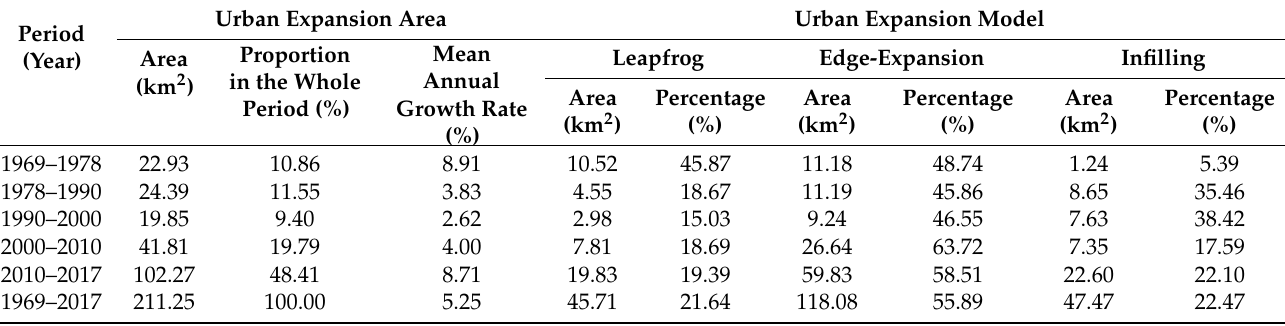
Figure 3. Urban expansion in Xining City. ( a ) spatial patterns of urban land; ( b ) changes in urban land area; ( c ) changes in patch density of urban land; ( d ) changes in the landscape shape index of urban land; ( e ) changes in the mean patch size of urban land; ( f ) changes in the mean altitude of the newly-added urban land; and ( g ) the urban expansion model. Table 1. The urban expansion area in Xining from 1969 to